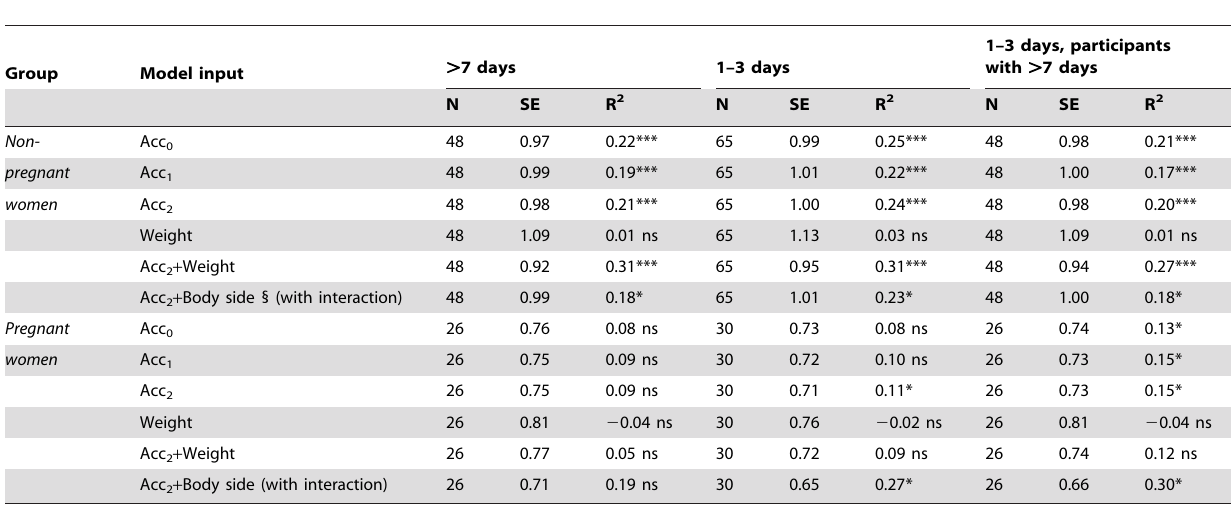
Table 2. Overview of regression models for predicting PAEE (MJ day 2 1 ), stratified by amount of accelerometer information used.